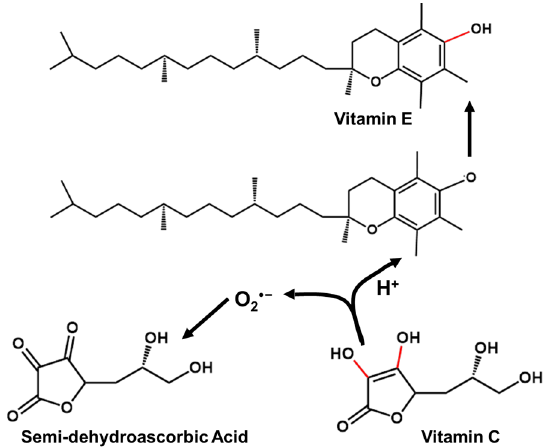
Figure 4. Antioxidative mechanism of vitamin C.